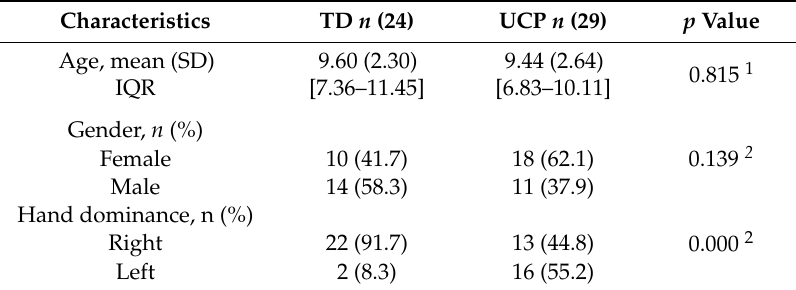
Table 1. Sociodemographic characteristics and hand dominance by